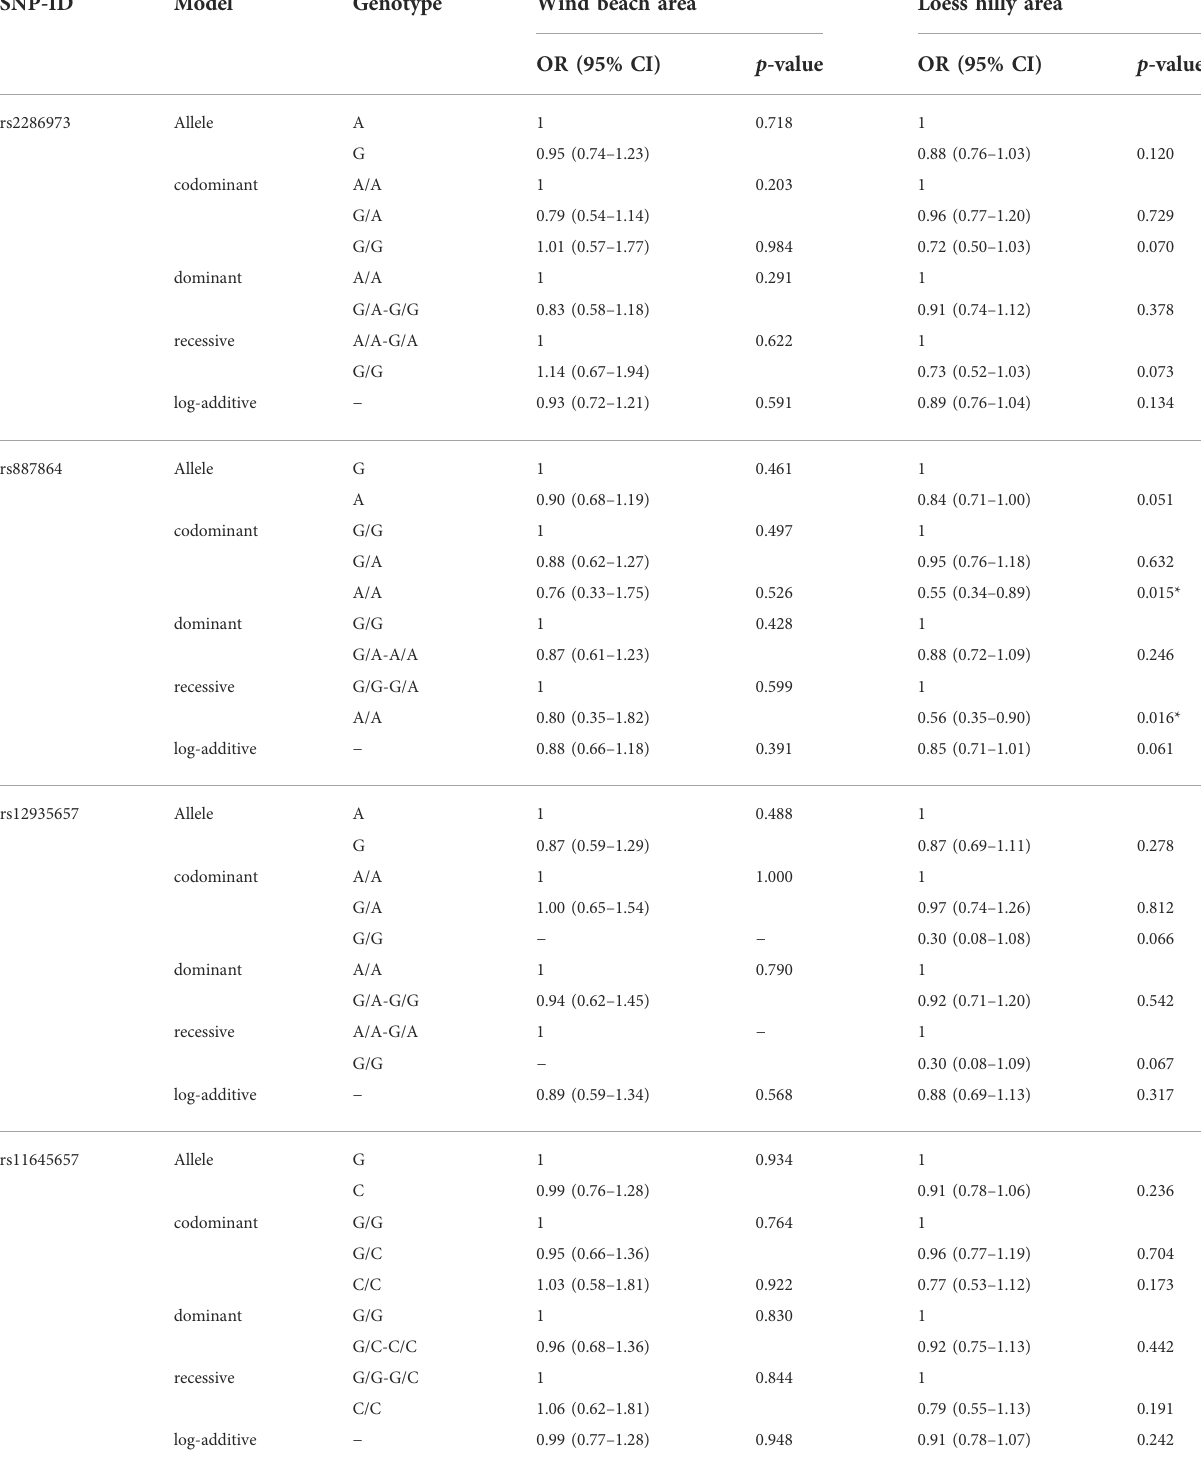
TABLE 6 Association between CLEC16A variants and AR risk strati fi ed by